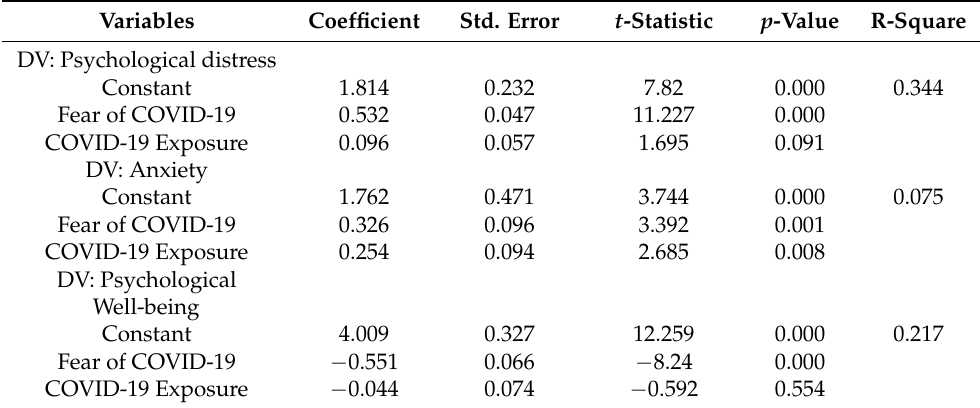
Table 4. Regression Analysis of COVID-19 Fear & Exposure and Mental Health.